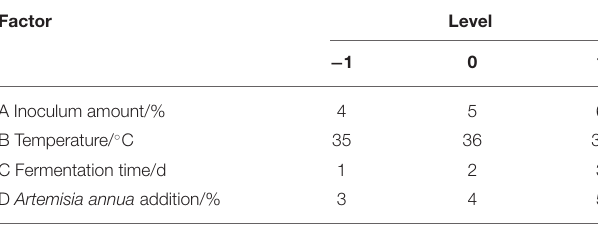
TABLE 1 | Response surface test factors and